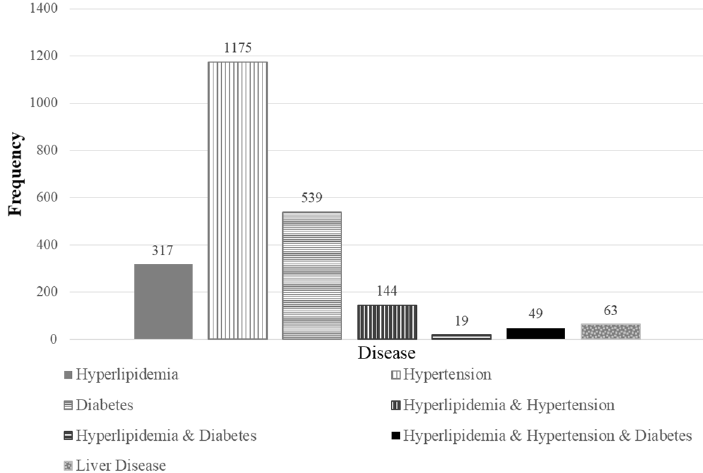
Figure 1. Frequency of the reported personal medications. Hyperlipidemia-associated diseases were extracted with the terms ‘hyperlipidemia’, ‘dyslipidemia’, ‘high blood pressure’, ‘hypertension’, and ‘diabetes’. Liver diseases were categorized with the terms ‘fatty liver’, ‘hepatitis’, ‘liver cirrhosis’, ‘liver disease’, and ‘elevated liver enzymes’. Table 5. The relationships between blood Hg and hyperlipidemia and elevated liver enzymes.